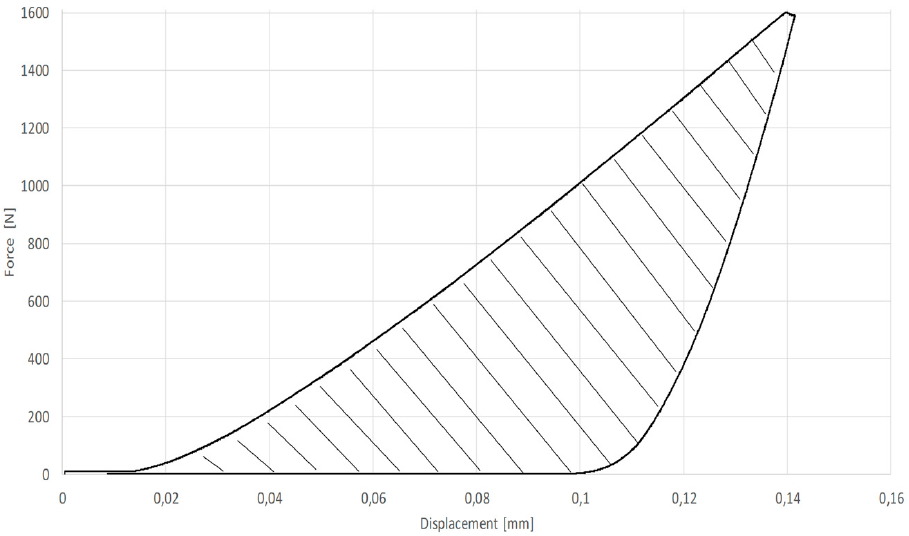
Figure 5. Force–displacement plot for indentation